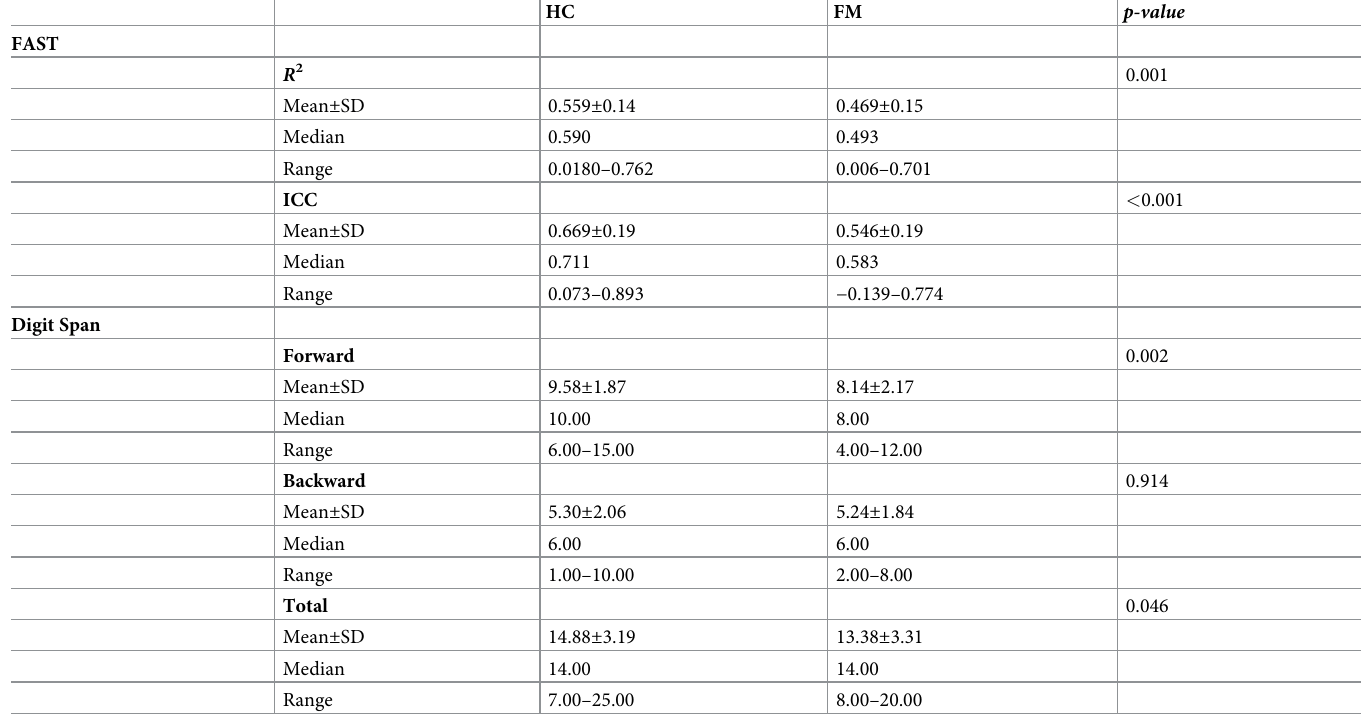
Table 3. FAST outcome measures and mean digit span scores. HC FM